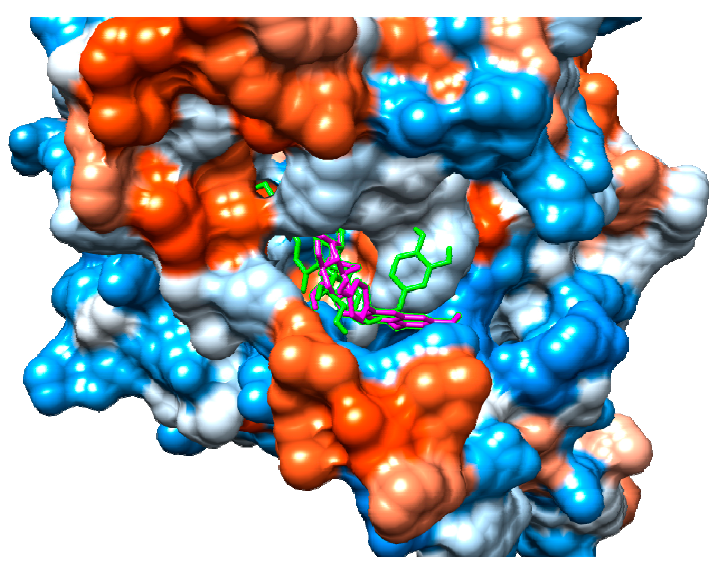
Figure 9. Spatial conformation of suspensaside (green) and nicotiflorin (magenta) on the COX-2 active site (PDB 1DDX). Image generated with USCF Chimera.